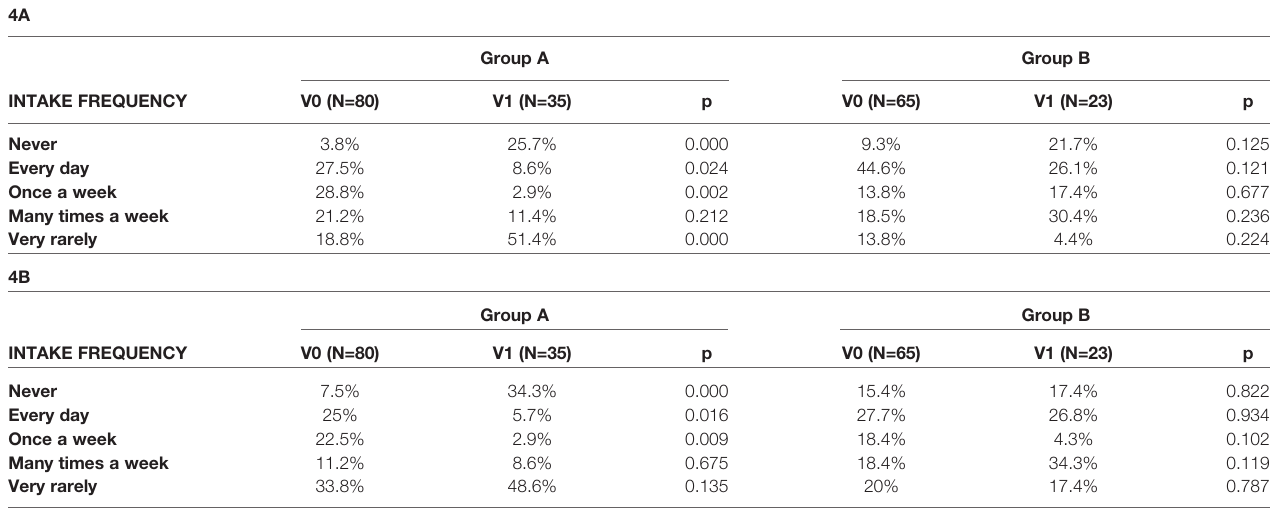
TABLE 4 | Intragroup comparison analysis concerning snack (4A) and sugar-sweetened beverage intake (4B) between baseline (V0) and 12-month evaluation